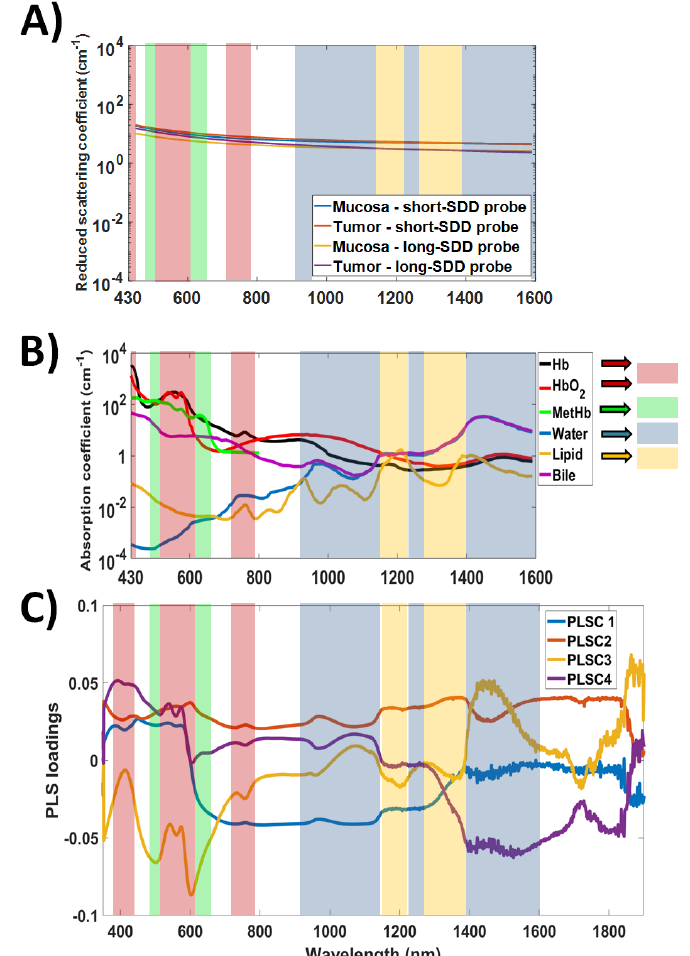
Figure 5. Wavelength regions with spectral features of mucosa and tumor scattering coefficients and each tissue chromophore shown at the ( A ) Reduced scattering spectra of mucosa and tumor tissues of both short-SDD and long-SDD probes, ( B ) chromophore absorption spectra and ( C ) PLSCs of the short-SDD probe.